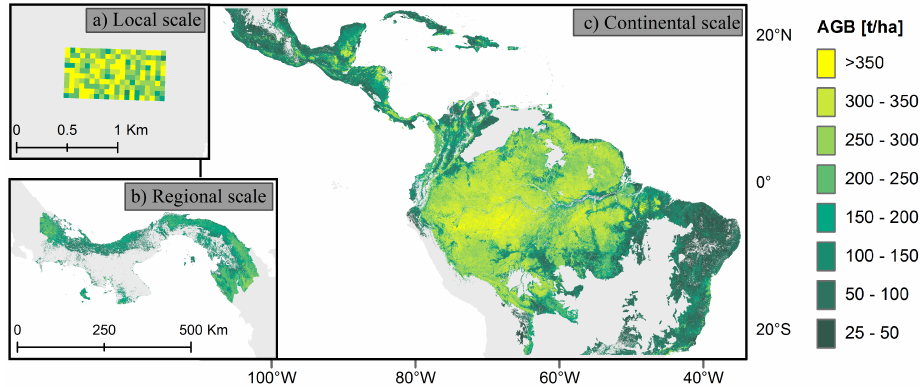
Figure 1. Forest aboveground biomass (AGB) maps used for the study. (a) Biomass map of a forest plot on Barro Colorado Island (50ha, 50m resolution). (b) Biomass map for Panama ( ∼ 50000km 2 , 100m resolution). (c) Biomass map for South America ( ∼ 11 × 10 6 km 2 , 500m resolution). For this study, we excluded all areas covering grasslands, savannas, and